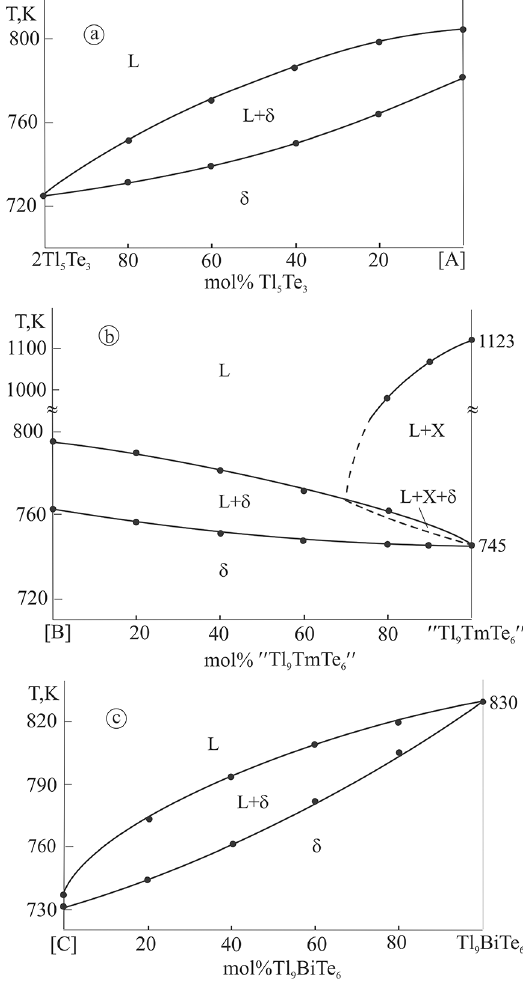
Te -[A], Tl TmTe -[B] and 5 3 9 6 Te -Tl BiTe -Tl TmTe 5 3 9 6 9 6 Figure 5. The liquidus and solidus surfaces projections and isothermal section at 760 K in the Tl of the Tl-Bi-Tm-Te quaternary system. Dash-dot lines show the investigated sections. A, B and C are equimolar compositions of the boundary